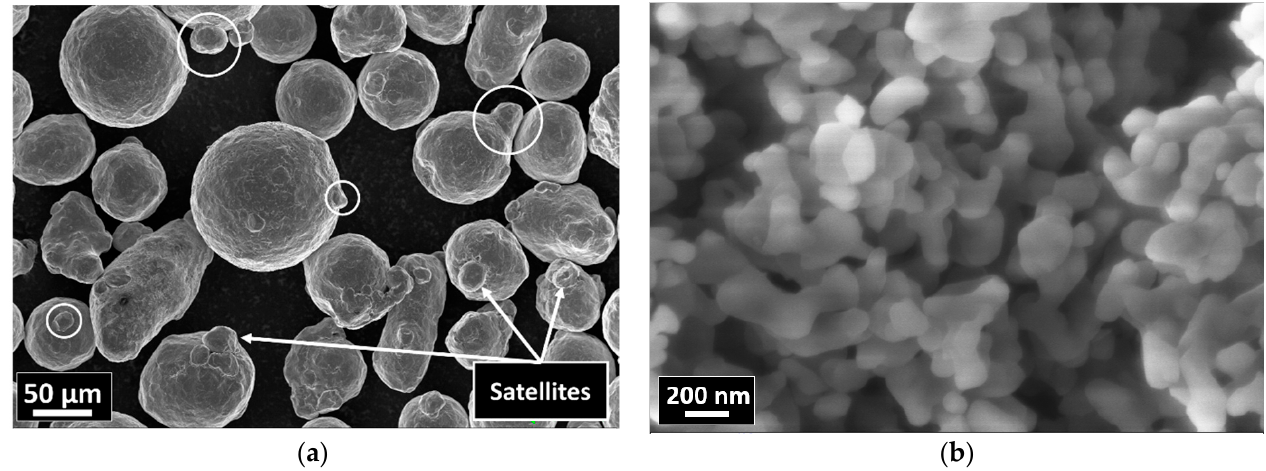
Figure 1. SEM images of the starting powders: ( a ) 316L; ( b ) Al 2 O 3 .